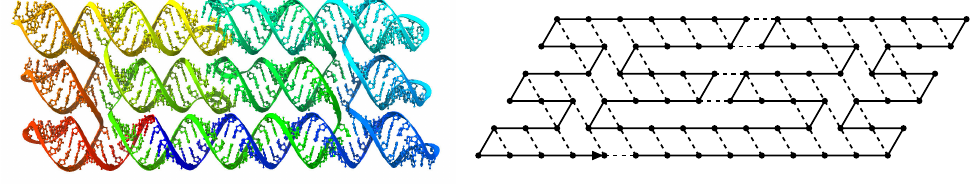
Figure 2. The design of a square, co-transcriptionally folded with RNA, and the corresponding path on the triangular